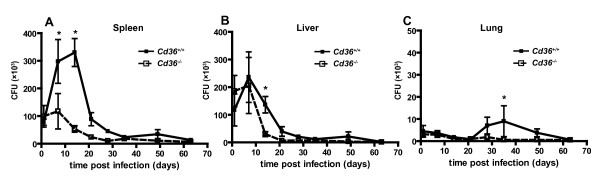
Cd36-/-mice have lower bacillary burden relative to Cd36+/+ controls after challenge with M. bovis BCG. A. Intraperitoneal infection (day 0) with BCG (1.5×107 organisms) resulted in a rise in mycobacterial counts in the spleens of Cd36+/+(wild type) mice to a maximum at day 14 with subsequent decline. The mycobacterial counts in Cd36-/- mice (white box, dashed line) were lower overall (p < 0.001), and at specific time points (day 7, *p < 0.01; day 14, *p < 0.001). B and C. Differences between genotypes were less pronounced in the liver (B) and lung (C). Results are displayed as mean ± SEM, with 8 mice per group at each time point, representing two pooled independent experiments.